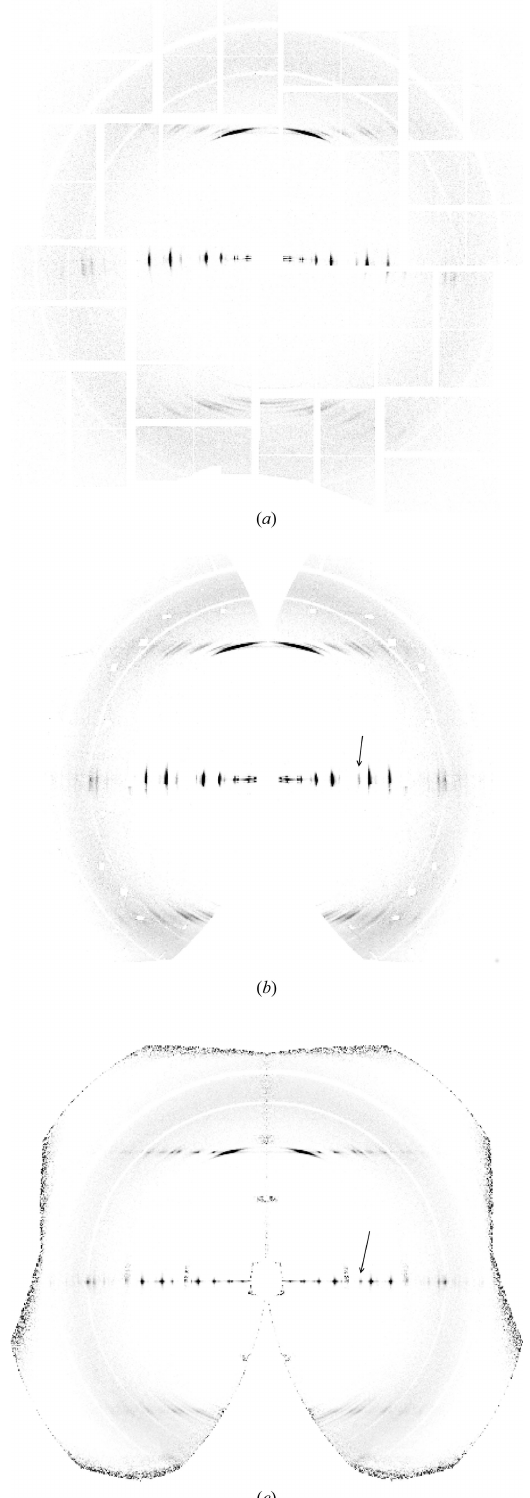
Figure 4 Averaged diffraction patterns ( a ) in detector space and ( b ) mapped into cylindrically averaged reciprocal space, using a tilt of 10 (cid:3) for each pattern. ( c ) Averaged diffraction pattern in reciprocal space after re-orientating each pattern in ’ and (cid:2) as described in the text. The arrows in panels ( b ) and ( c ) show the equatorial reflection used to evaluate the orientation, as described in Section 4.4.